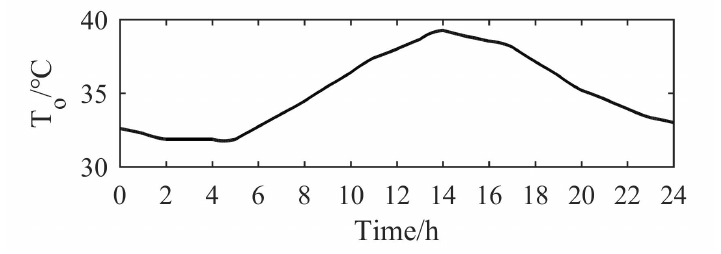
Figure A1. Outdoor temperature.